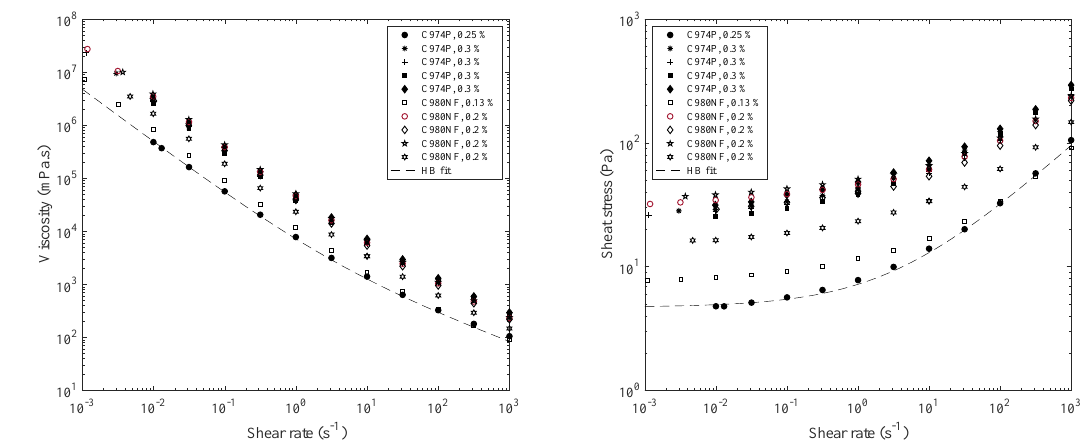
Figure 1. Flow curves of gel tears at 25 °C: yield stress and very high viscosity at a low shear rate and decreasing viscosity during a blink (high shear rate). The grey lines represent the Herschel–Bulkley model (Equation (1)) applied to the product with the lowest yield stress. Table 1. Results for gel tear substitutes at 25 °C.